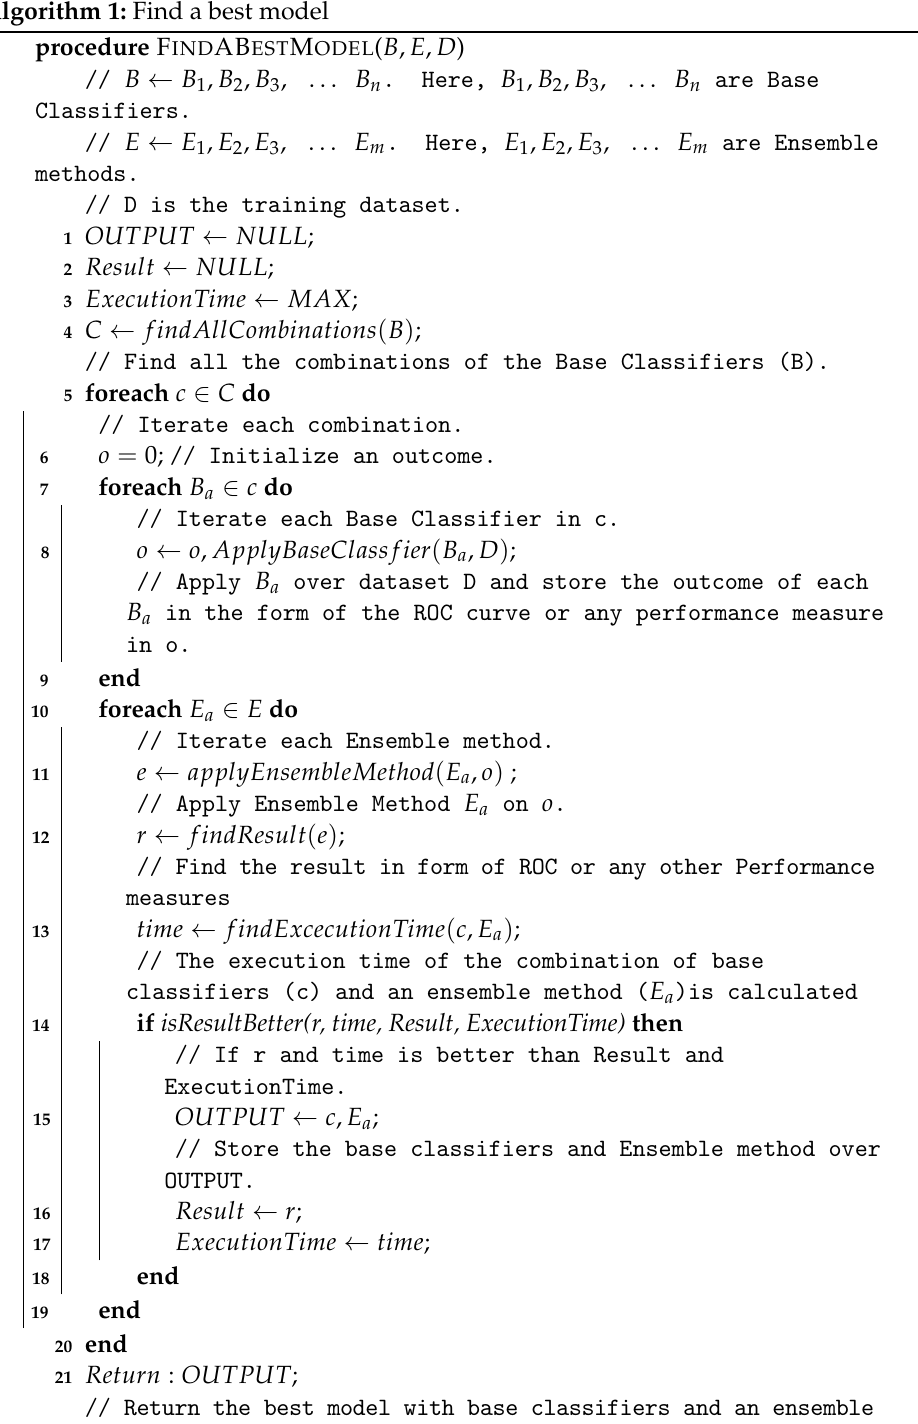
Algorithm 1: Find a best